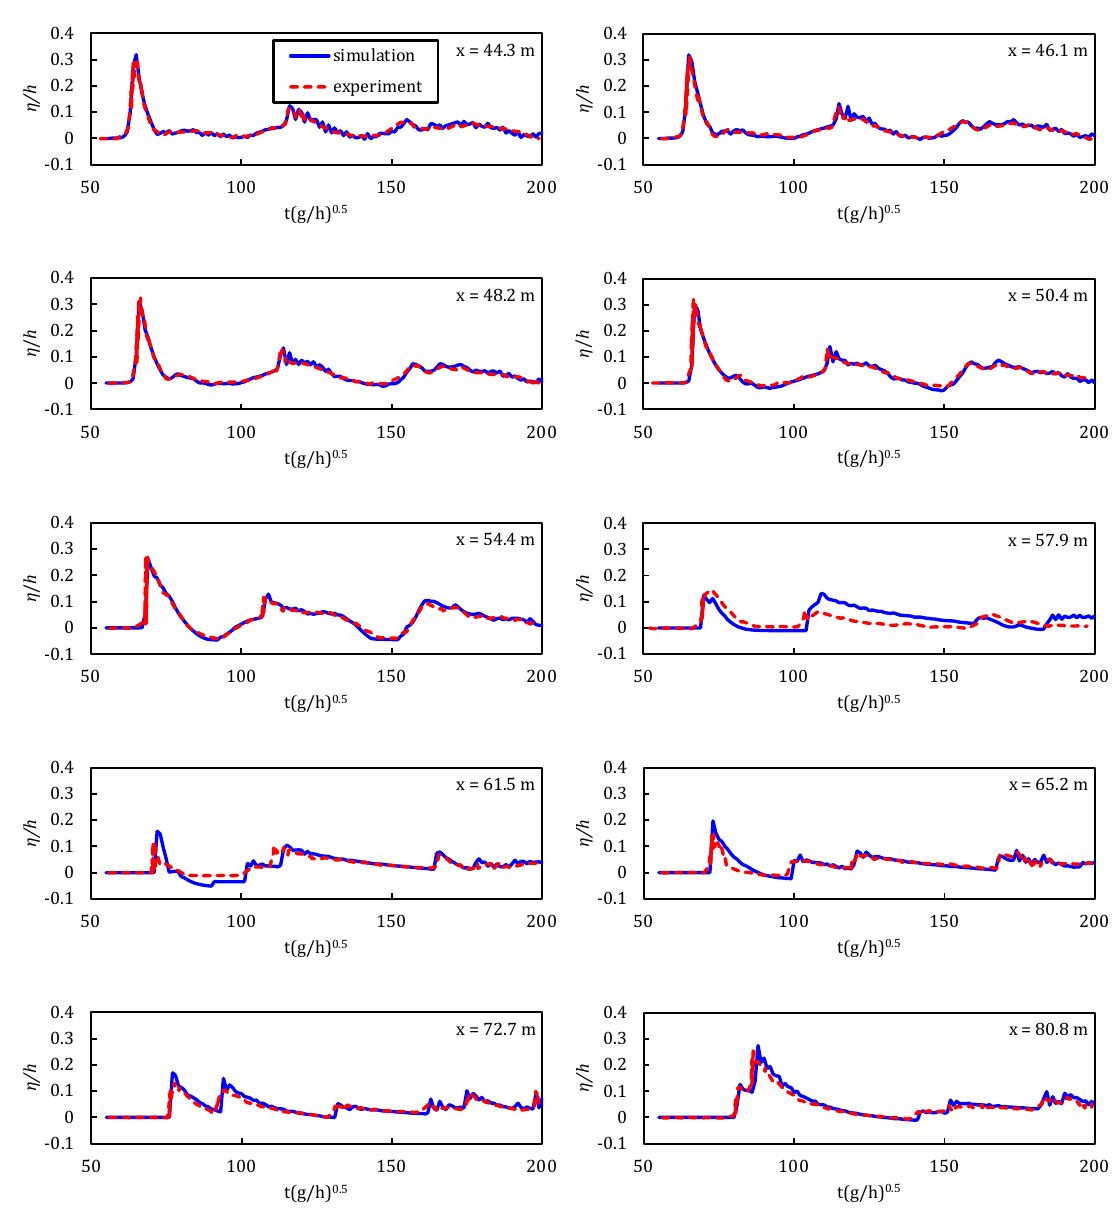
Figure 9. Comparison of simulated and measured time series free surface elevations for a solitary wave propagation over an exposed reef